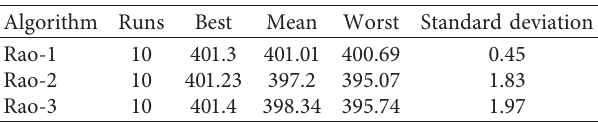
Table 4: Best, mean, and worst objective function values obtained corresponding to the optimal solution using Rao algorithms for the DFRO system